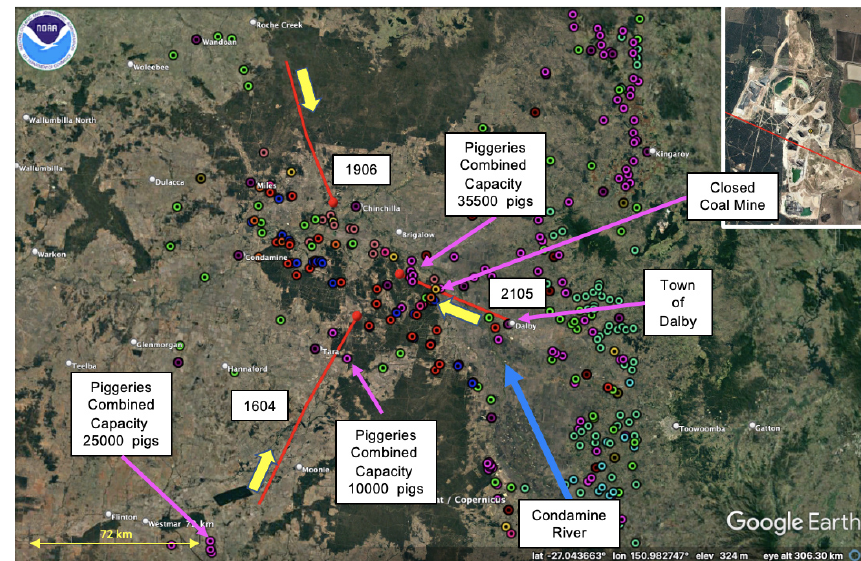
Figure 7. Two-hour back-trajectory path lines (red) for IFAA samples 1604, 1906, and 2105. Refer to Fig. A1 for the point source colour key. Yellow arrows show the wind direction. The Condamine River flows from southeast to northwest (blue arrow) (image © Google Earth).